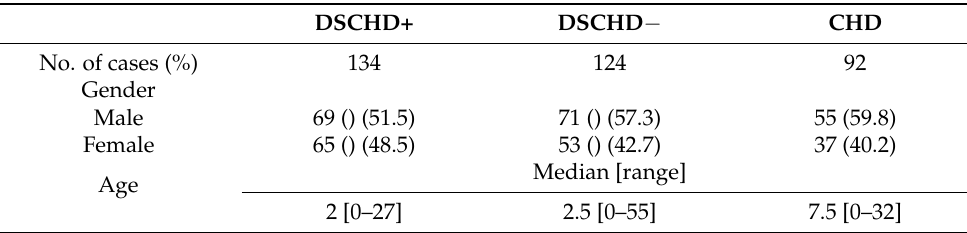
Table 1. Characteristics of the study